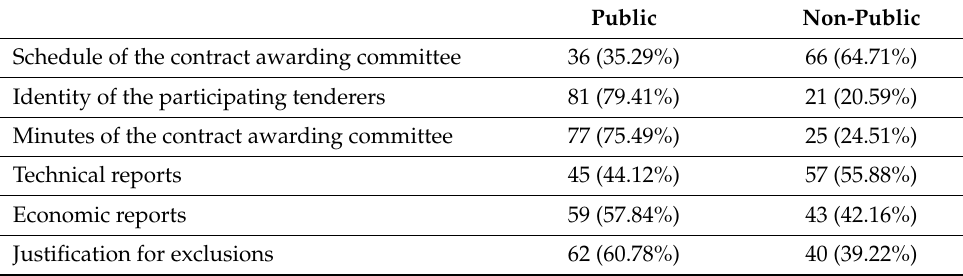
Table 2. Dissemination of information during the award